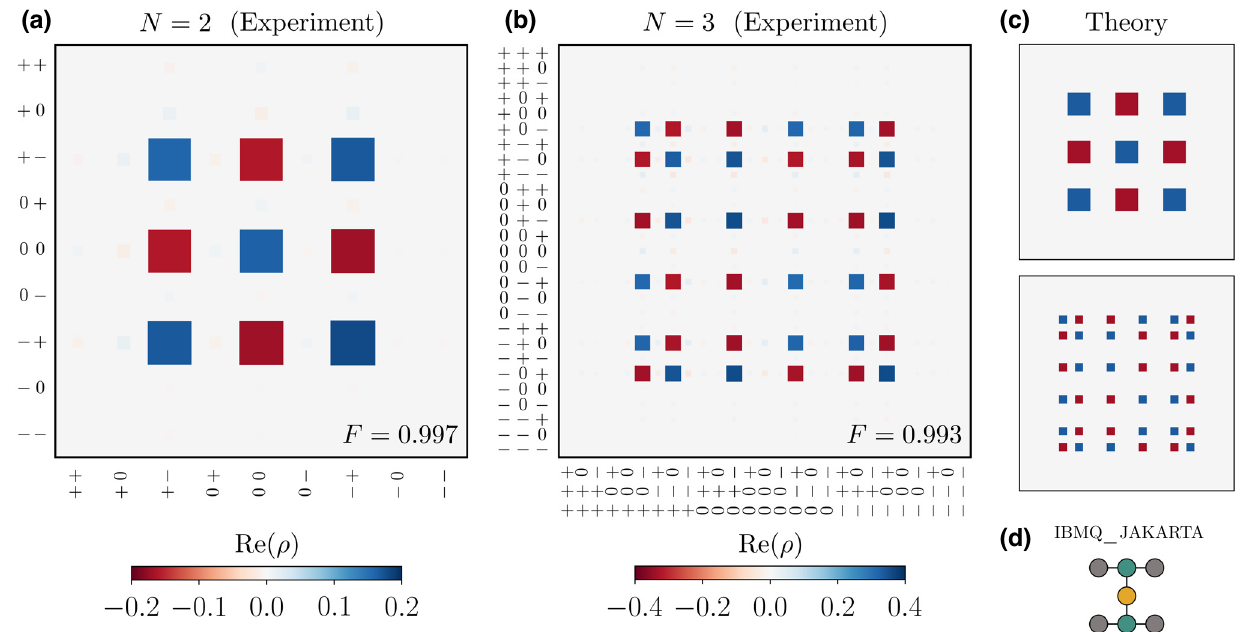
FIG. 5. The reconstructed density matrix of AKLT chains with periodic boundary conditions prepared on an IBM Quantum pro- cessor. For both N = 2 and N = 3 sites, we perform a full set of Pauli measurements, each consisting of 10 5 shots. We postselect on measurement of valid spin-1 states and use McWeeny purification to obtain a maximum-likelihood pure state ρ . The computed likelihood of ρ is 88% and 65% for N = 2 and N = 3, respectively. In both cases, Im (ρ) is expected to vanish. (a) A Hinton dia- gram of Re (ρ) for N = 2 sites, with max ( Im (ρ)) = 0.019 and fidelity F (ρ , ρ AKLT ) = 0.997 between the maximum-likelihood